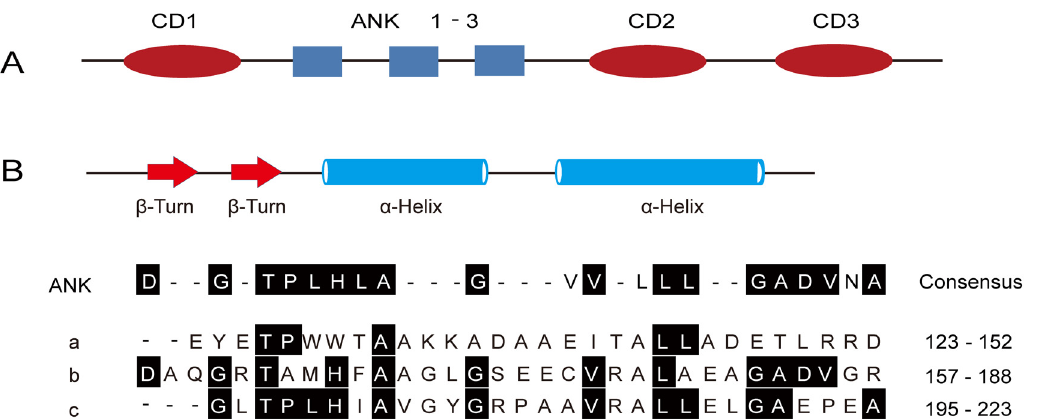
Fig 5. Domain organization of OscpSRP43 and structural details of ANK 1 – 3. A, OscpSRP43 is composed of three CDs (red ellopses) and three ankyrin repeats (grey boxes); B, Structure of ankyrin-repeat domains (ANK1, residues 123 – 152; ANK2, 157 – 188; ANK3, 194 – 223). CD, chromodomain; ANK, anyrin-repeat